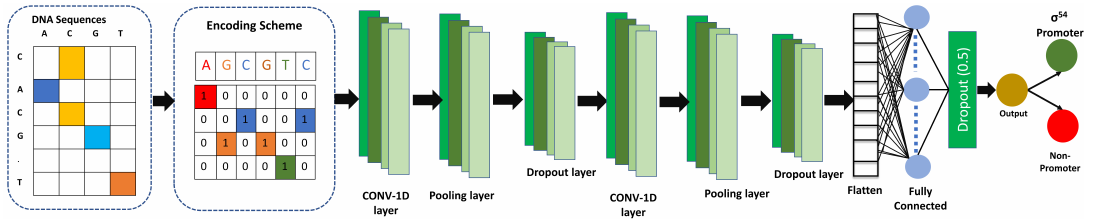
Figure 2. iProm-Sigma54 CNN Model Architecture. The CNN model consists of two one-dimensional convolutional layers, followed by max-pooling layers and dropout